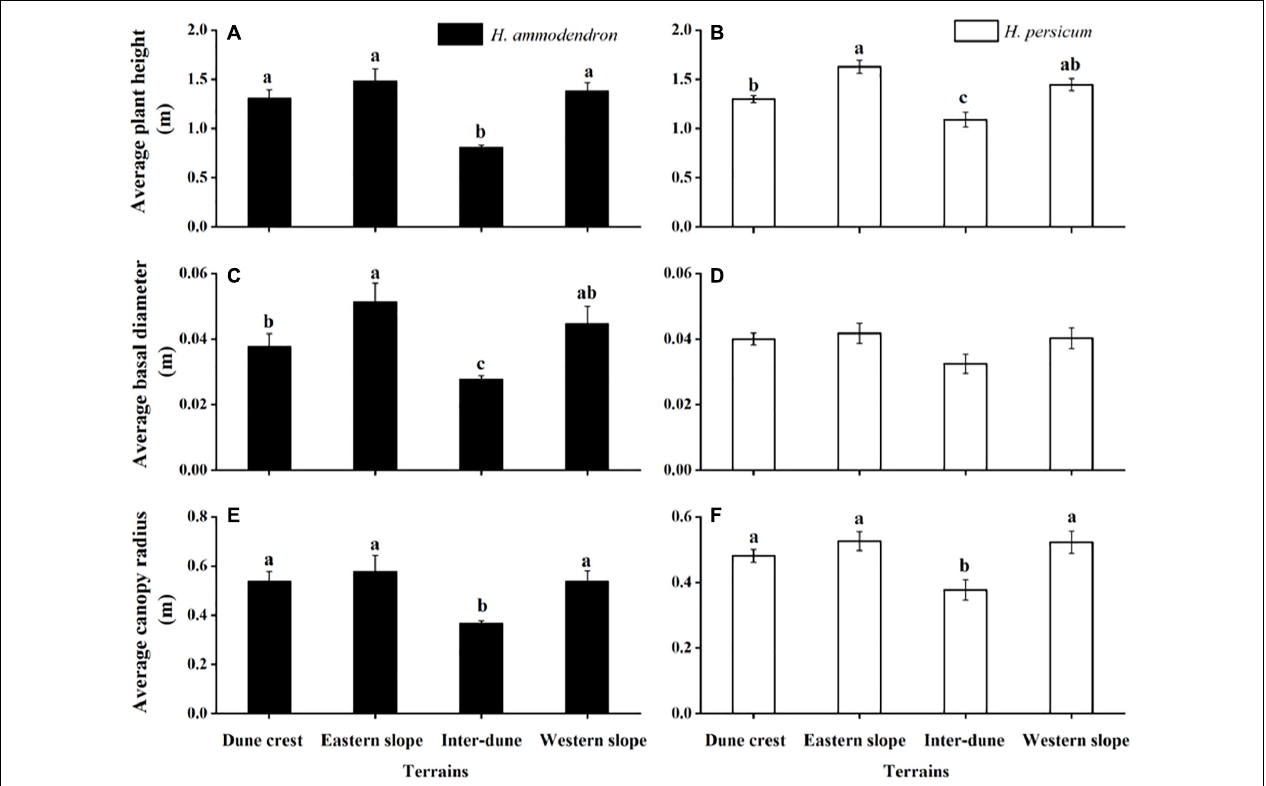
FIGURE 5 | Morphological characteristics of Haloxylon ammodendron (A,C,E) and H. persicum (B,D,F) at different terrains. Different letters represent significant differences ( p < 0.05). Data are presented as the mean ± 1 standard error. TABLE 2 | Results for SMA fitted slopes between plant height and canopy radius of Haloxylon ammodendron and H. persicum at different terrains. Plant Height vs. Canopy